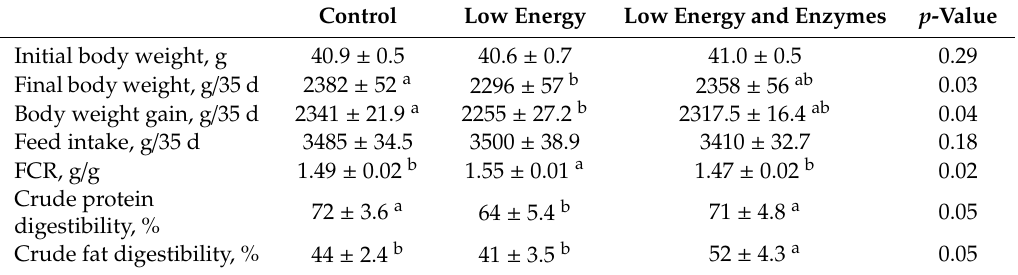
Table 2. E ff ect of non-starch polysaccharide (NSP) enzyme supplementation on growth performance in broilers.